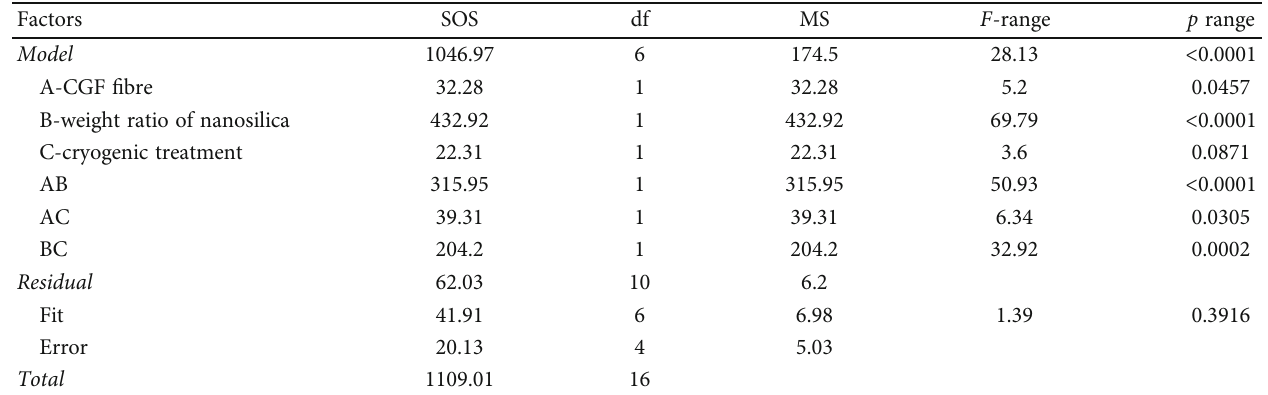
Table 4: ANOVA for bending behaviour.